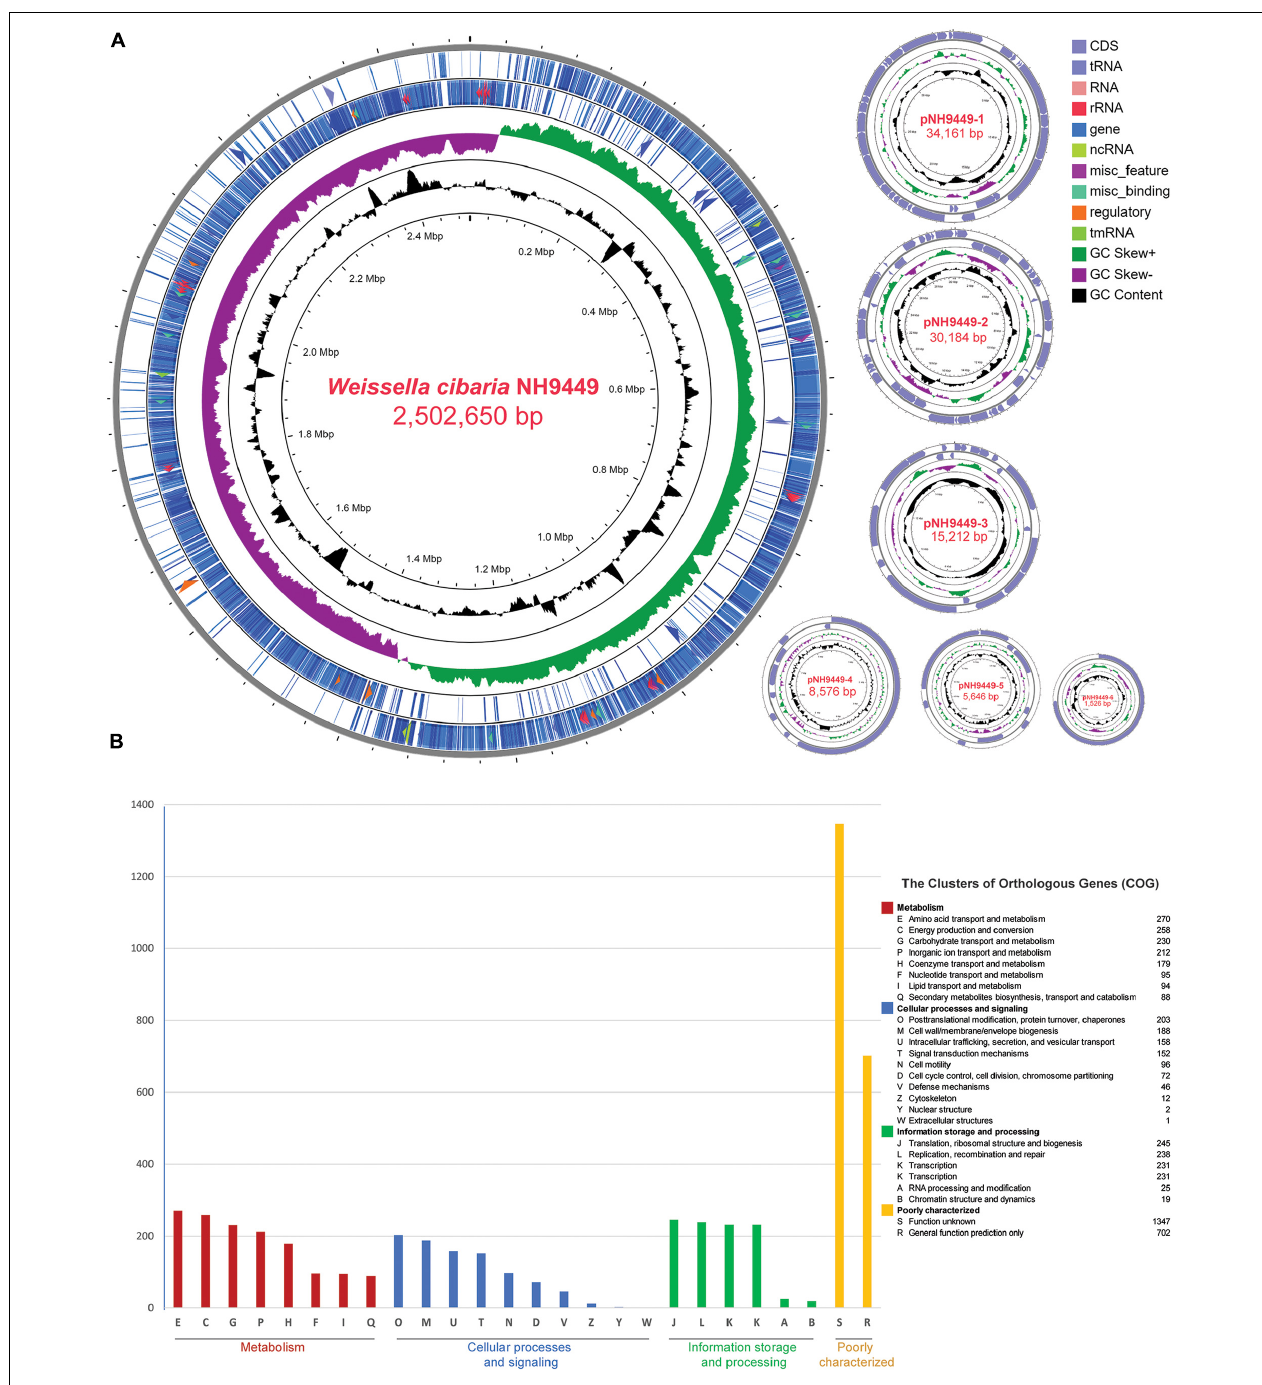
FIGURE 1 | Genome visualization and annotation of W. cibari a NH9449. (A) Circular genome representation of chromosome and six plasmids. The element color of each circle is indicated in the legend. The following rings provide this information: forward strand CDS, reverse strand CDS, GC Skew, CG content, respectively. tRNA, RNA, rRNA, ncRNA, regulatory, and tmRNA are also located at the same ring of CDS based on their strand. (B) Clusters of Orthologous Groups (COG) identification of W. cibari a NH9449